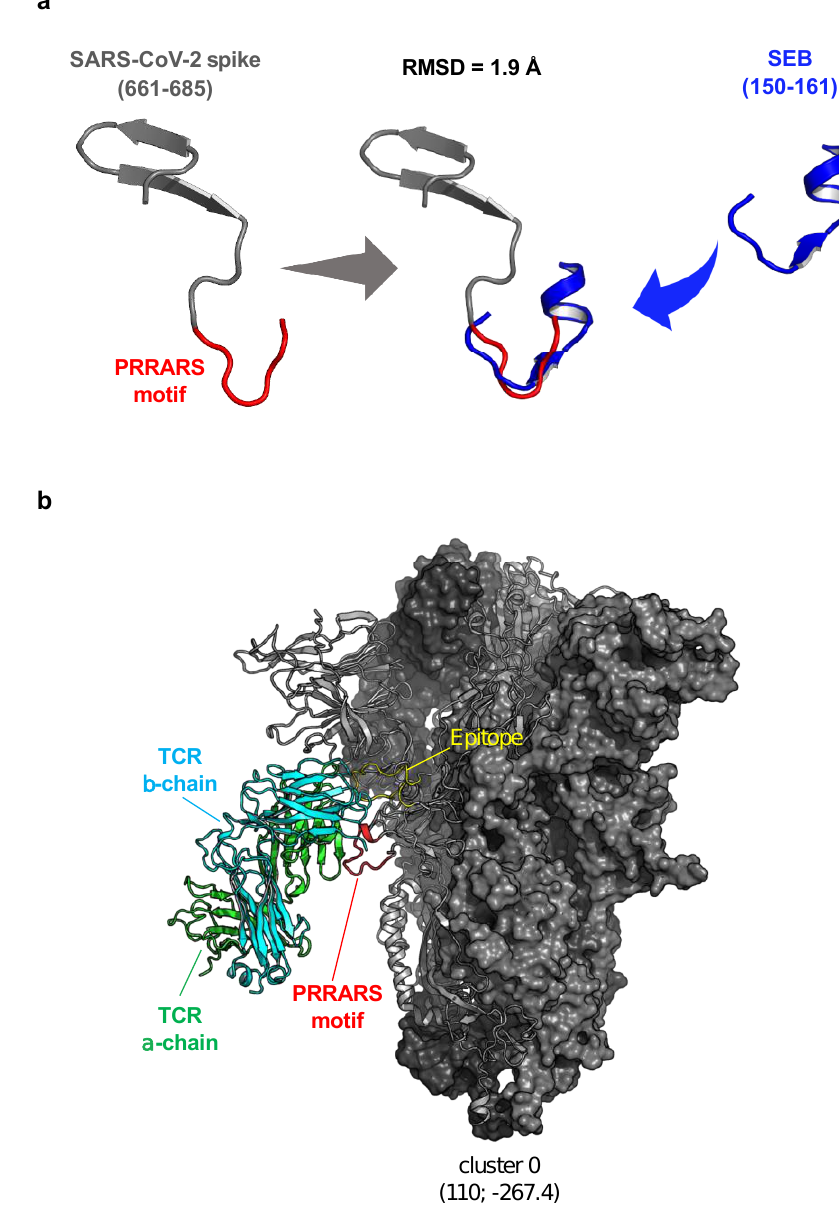
Figure 5. Structural prediction of the putative interaction between SARS-CoV-2 spike and TCR. ( a) Structure superposition of SEB superantigenic fragment (150 – 161; blue) and the sequence of SARS- CoV-2 spike near the PRRARS insert (661 – 685; dark grey and red). ( b ) Top-1 cluster representative of SARS-CoV-2 spike and the human TRAV27/TRBV19 [61] complex, as predicted by ClusPro 2.0. The SARS-CoV-2 spike trimer is shown in grey, with the interacting chain as cartoons and the others as surface. The αβTCR structure (PDB: 2XN9) is represented as green (TCR α -chain) and cyan (TCR β -chain) cartoons. The PRRARS insert of the spike protein is coloured in red. The epitope that is recognised is coloured yellow. The number of representative structures within the cluster and the mean energy is shown in parenthesis. We next repeated the protein – protein docking approach, using the same previously described input data [19] and a recently developed mode of ClusPro 2.0 for use with Im- munoglobulin (Ig)-like structure docking [59]. This method is known to produce much better results compared to the ClusPro 2.0 standard approach due to the use of the new potentials significantly improving the performance of docking for Ig – protein antigen